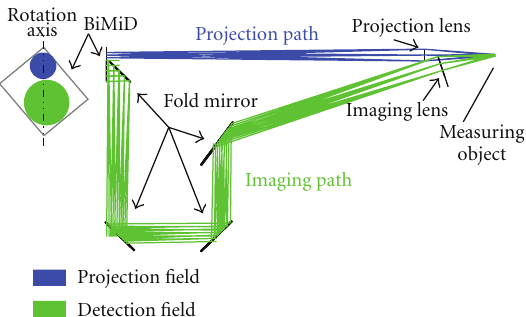
Figure 6: Paraxial optical system setup of the 3D sensor. On the left-hand side a top view of the BiMiD is shown and on the right-hand side the paraxial lens setup is shown.The projection and detection fields are oriented to reach the best fill factor for the microdisplay. Due to this e ff ect the display is rotated for the paraxial system simulation. Projection and detection fields are orientated perpendicular. At the paraxial lens setup the bi-directional OLED microdisplay is positioned on the left side and on the right side the measurement object (e.g., sinusoidal mirror element) is placed. The blue ray path describes the projection and the green one describes the imaging path.